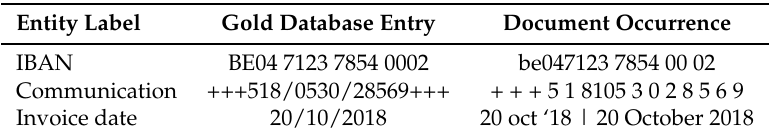
Table 3. Examples that illustrate the difference between a gold database entry and its occurrence(s) in a document’s